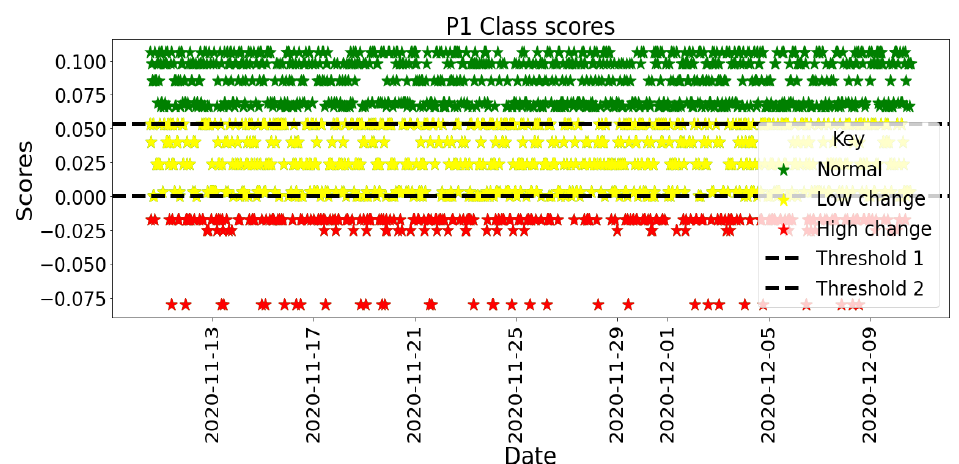
Figure 25. Further Change Division for P1.